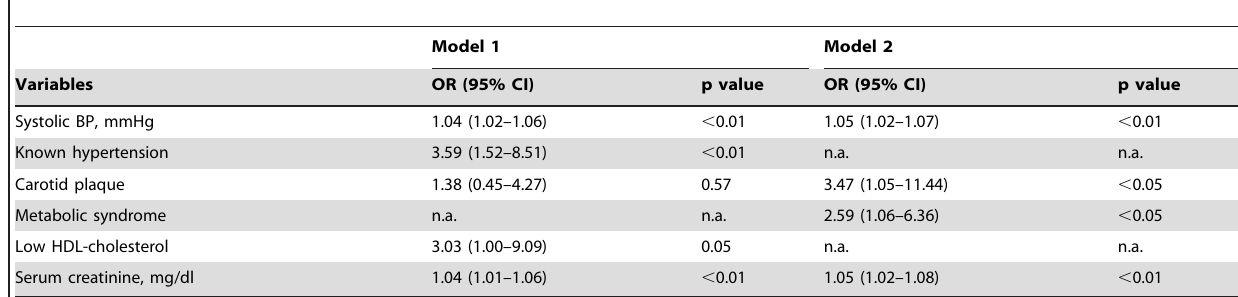
Table 5. Independent covariates of high for age PWV in multiple logistic regression